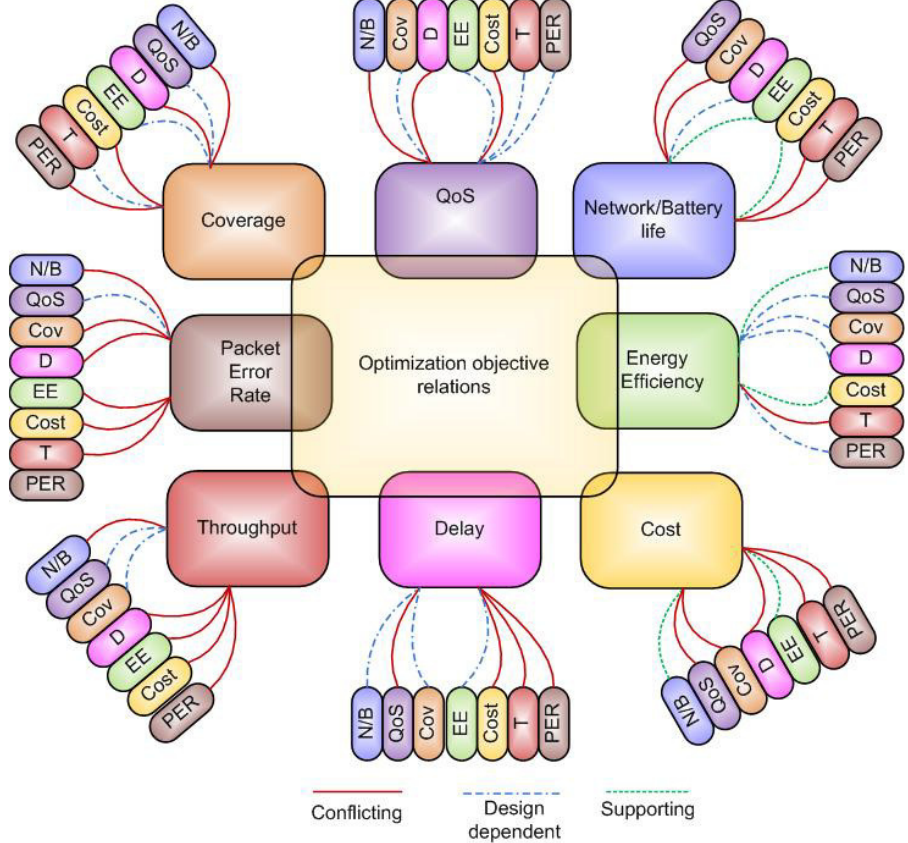
Figure 3. Relation between desirable objectives in wireless sensor networks (WSNs), where “N/B” = network/battery life; “QoS” = quality of service; “Cov” = coverage; “D” = delay; “Cost” = total cost of the system; “T” = throughput of the system; “EE” = energy efficiency; “PER” = packet error